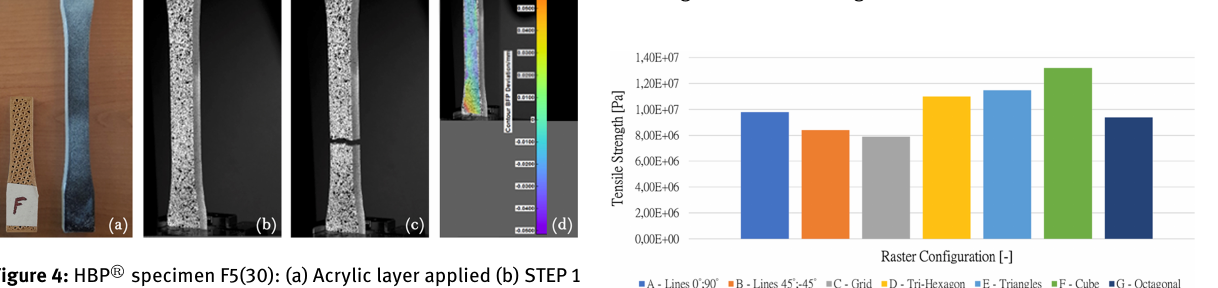
Figure 5: Comparison of specimen classes with Tensile Break [Pa]